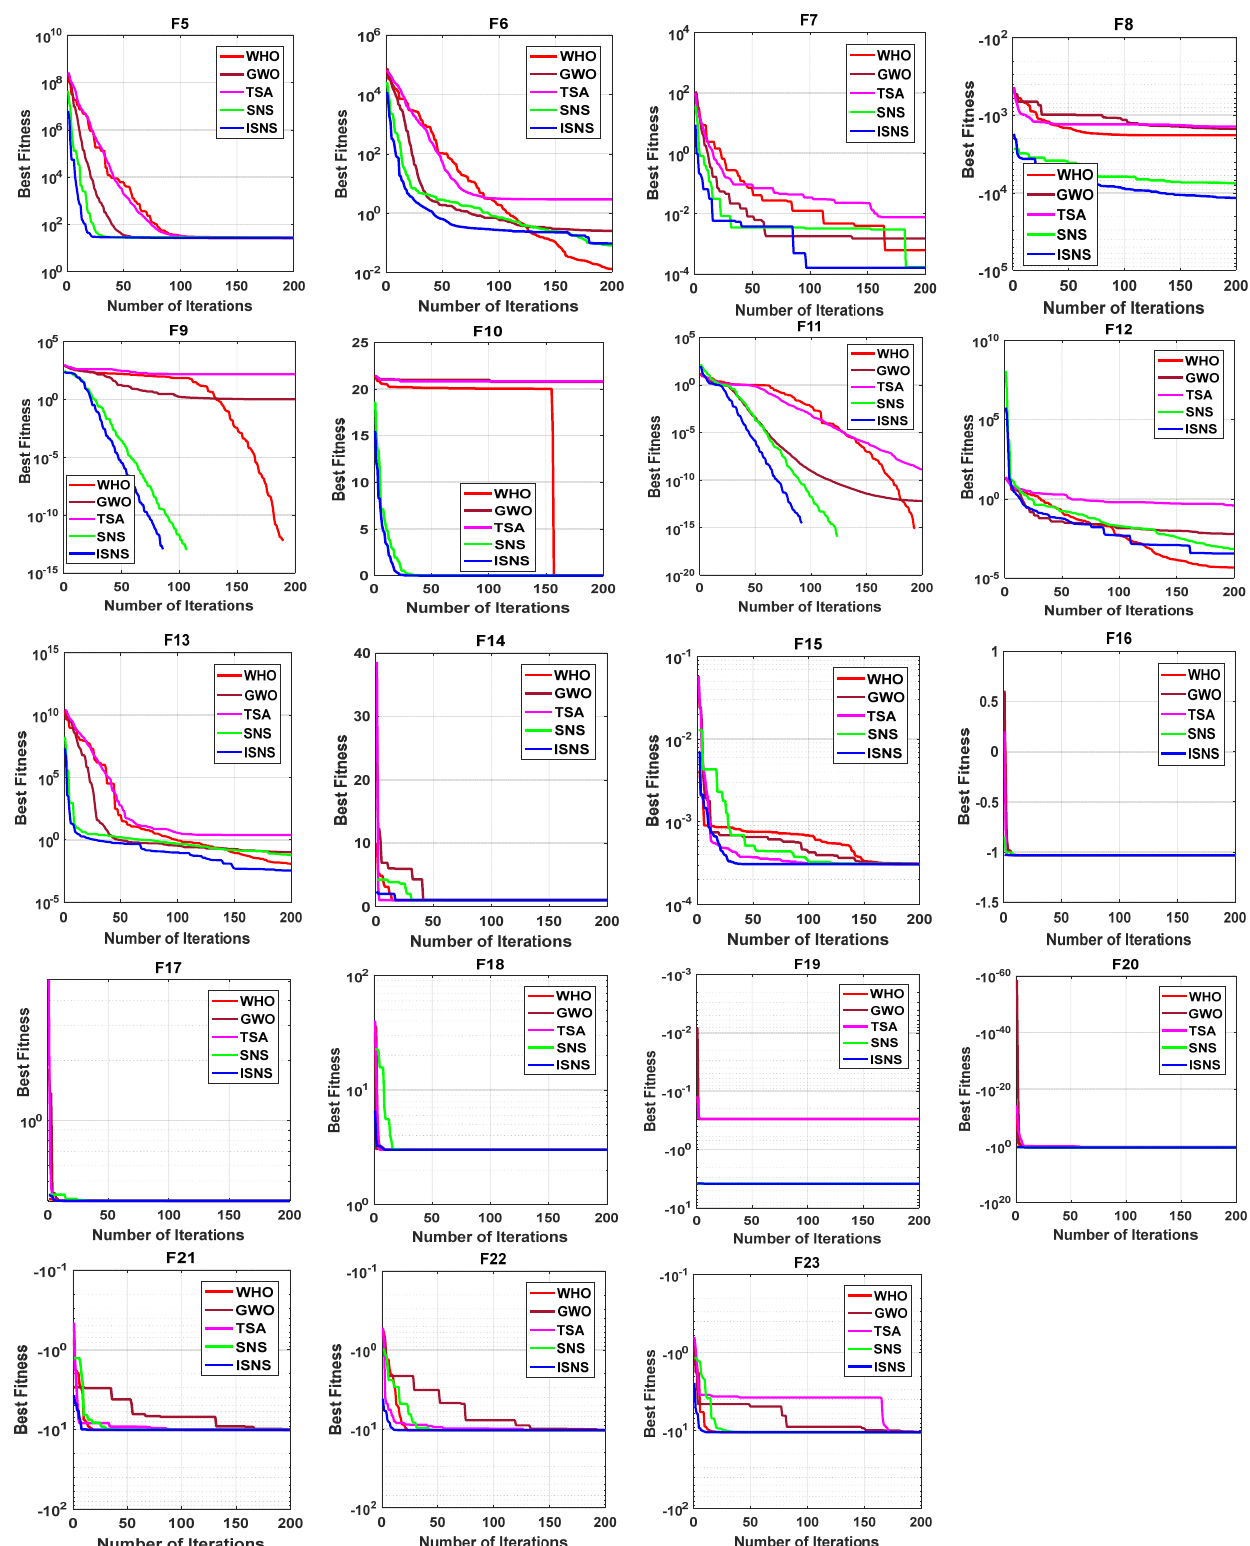
Figure 11. The convergence curves of all algorithms for 23 benchmark functions.